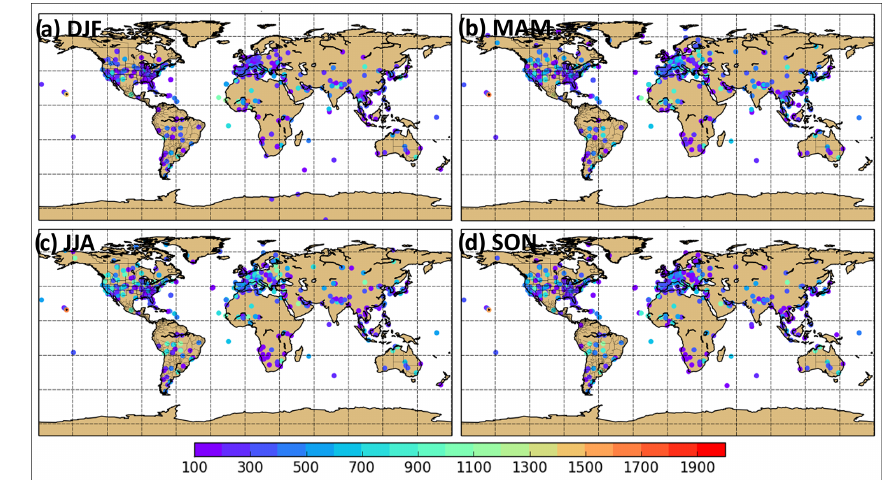
Figure 2. Count of daily-averaged AERONET AOD and PW data points by season: (a) DJF, (b) MAM, (c) JJA, and (d) SON. Only sites with at least 100 points are